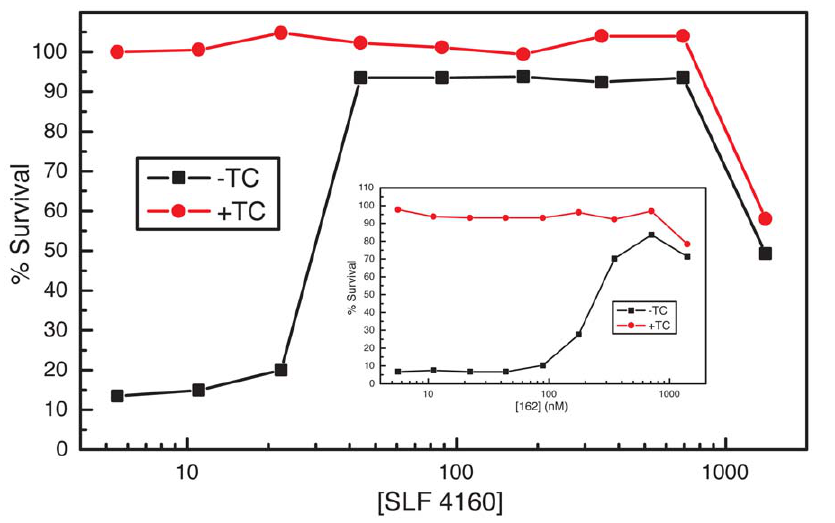
Figure 2. SLF HO-4160 protects against A b O toxicity in cultured neurons. Plotted are the viability values for neuroblastoma MC65 cells with conditional APP-C99 expression as a function of compound concentration. The protective effect against A b O toxicity exceeds that of the previously described base compound, K01-162 (insert).